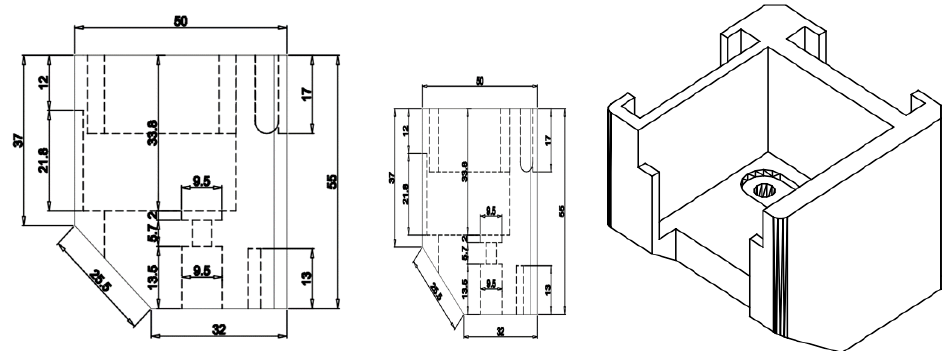
Figure 8. Drawing/layout of the power cord.